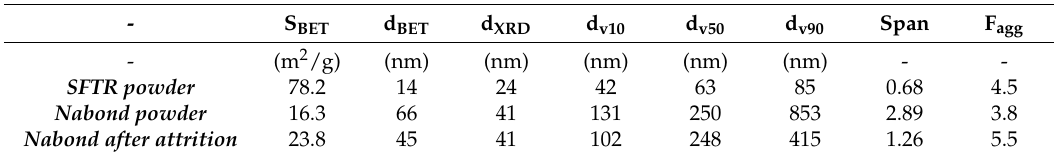
Table 1. Comparison of ZnO nanopowders properties: Brunauer-Emmett-Teller (BET), X-ray diffraction (XRD) and